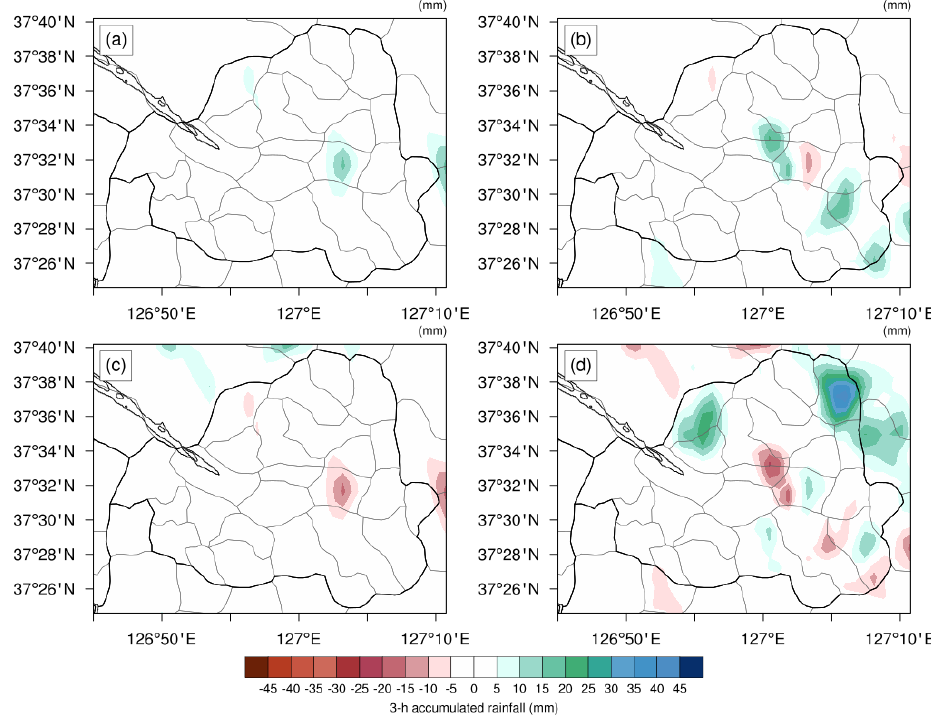
Figure 10. 3-h accumulated rainfall (mm) ( a ) unrelated to either sea or urban, ( b ) induced by sea, ( c ) induced by urban, and ( d ) induced by the interaction between sea and urban from 1500 to 1800 LST.